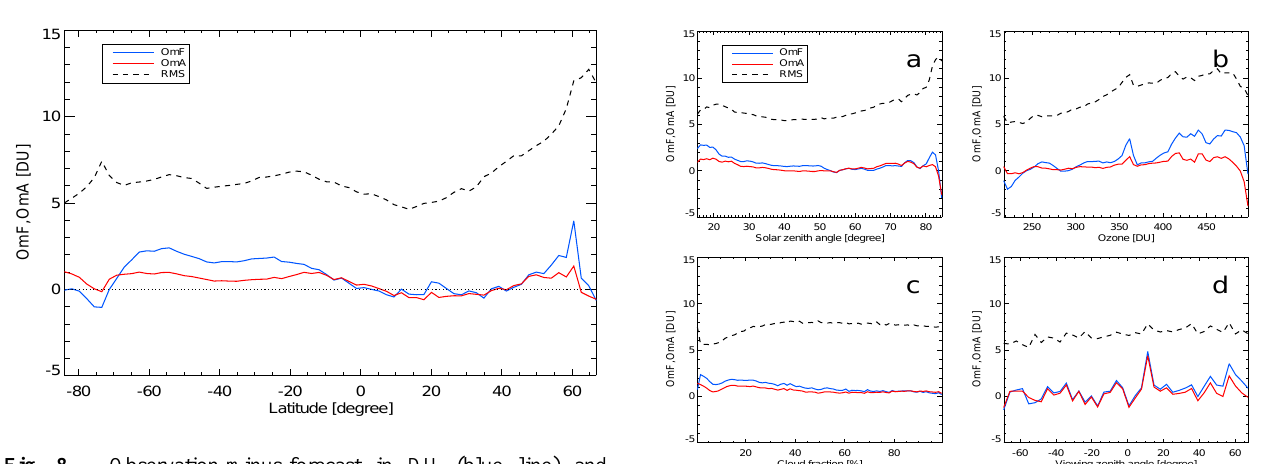
Fig. 8. Observation-minus-forecast in DU (blue line) and observation-minus-analysis (red line) as a function of latitude. The dashed black line represents the RMS value of the observation- minus-forecast distribution. All data are averaged over January 2008.